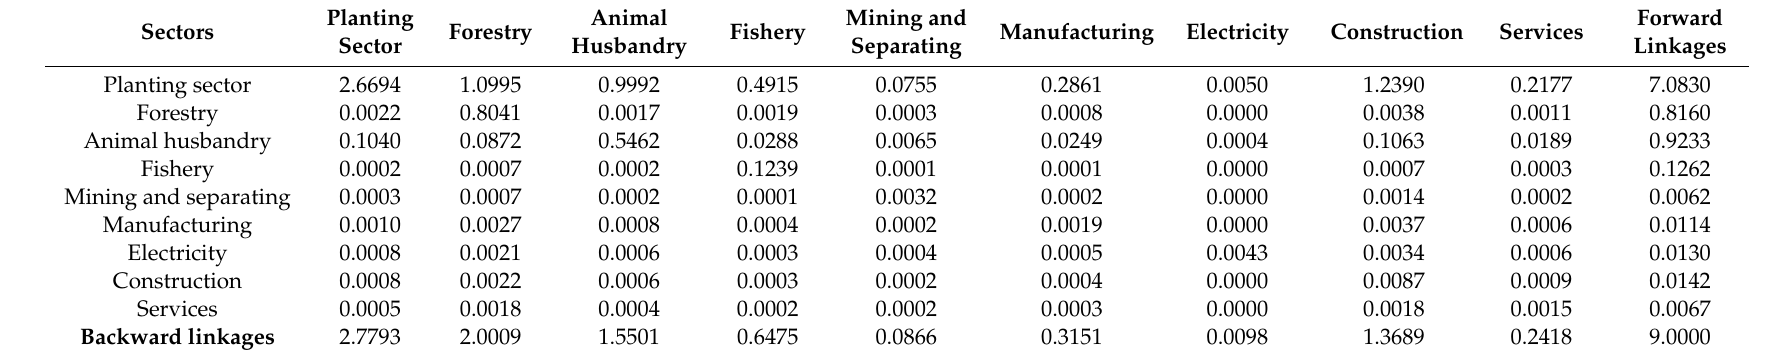
Table A2. Normalized matrix of backward and forward reallocation linkages for blue water in economic sectors. Sectors